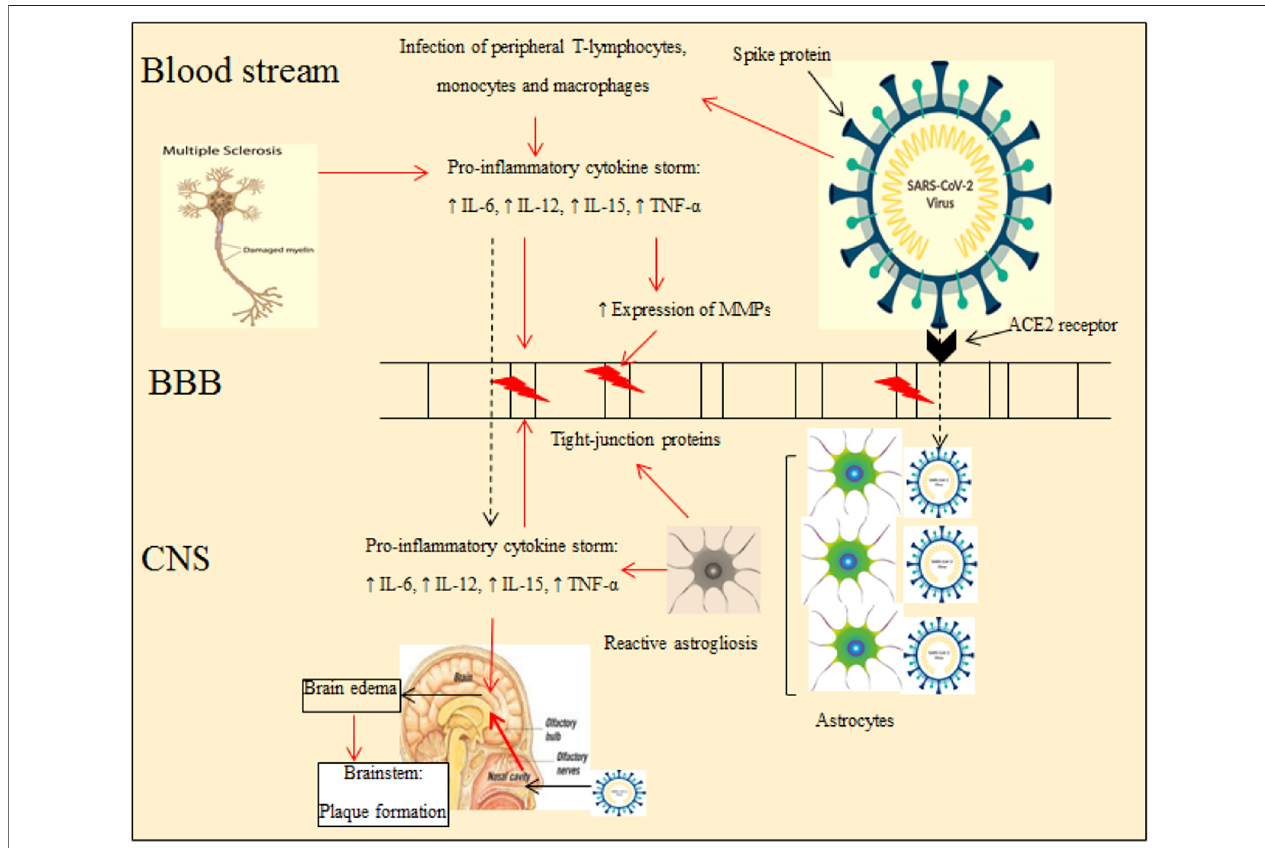
FIGURE 1 | Neuro-invasive mechanisms of SARS-CoV-2 and common effects of COVID-19 and MS diseases on brain and its components. Hyper-in fl ammation induced by MS and coronavirus increases BBB permeability and plaque formation in the brainstem. Reactivation of astrocytes induced by pro-in fl ammatory cytokines alsoimpactstheBBB.Theredarrowsindicatethedetrimentaleffectsofin fl ammationproducedbybothMSandSARS-CoV-2(ACE2,angiotensin-convertingenzyme2; MMPs, matrix metalloproteinases; MS, multiple sclerosis; CNS, central nervous system; BBB, blood-brain barrier).